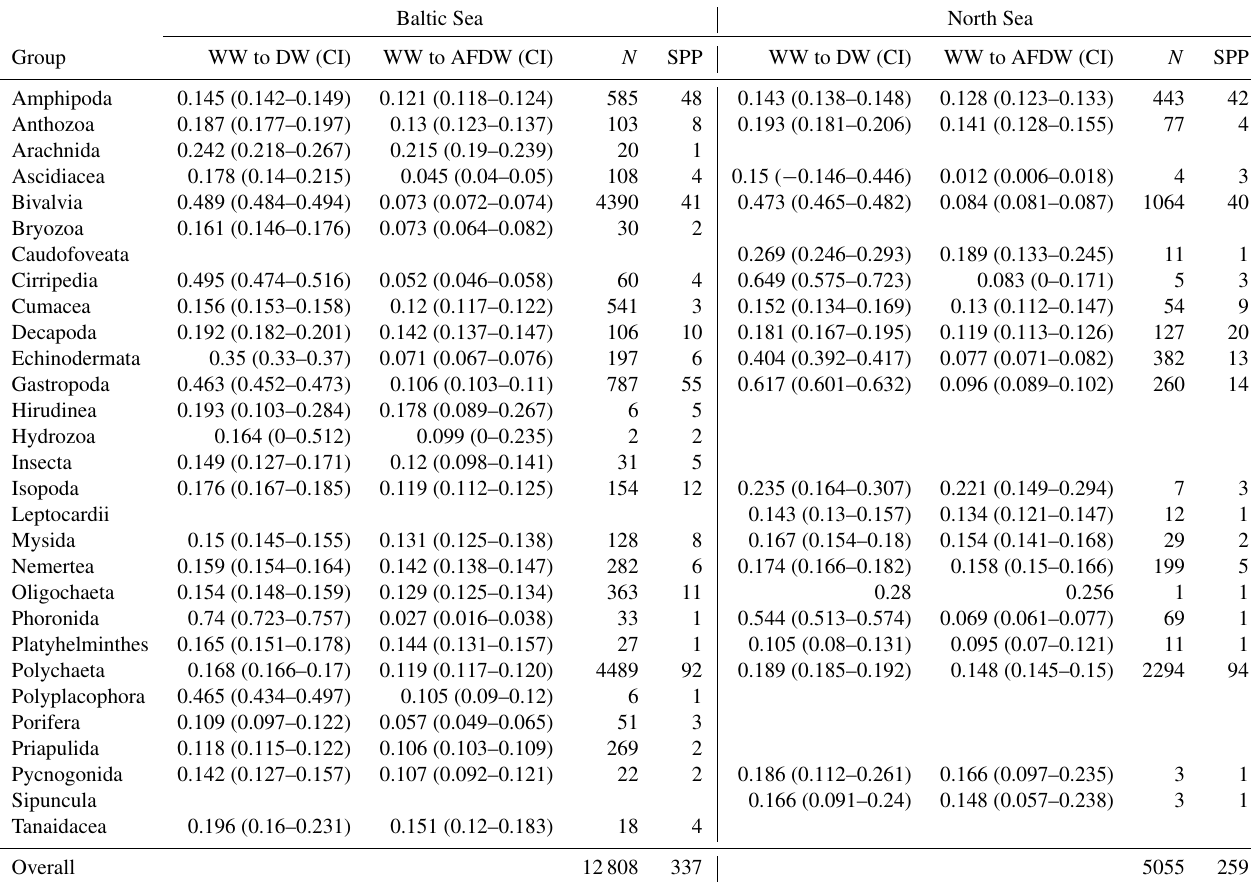
Table 2. Weight-to-weight conversion factors for 29 major functional groups, differentiated by region, based on all raw values per taxa included in the group: AFDW: ash-free dry weight; WW: wet weight; DW: whole dry weight; CI: 95% confidence interval; N : number of values; SPP: number of species (taxa) per